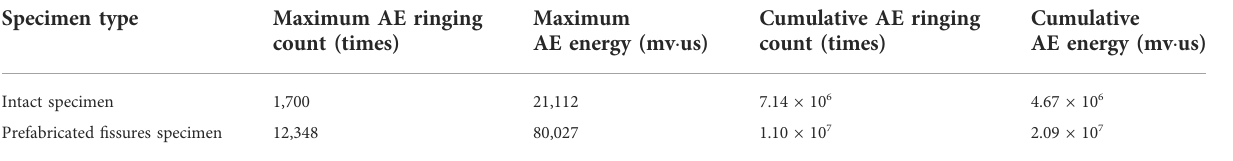
TABLE 4 AE ringing count and AE energy of specimens under the last stress